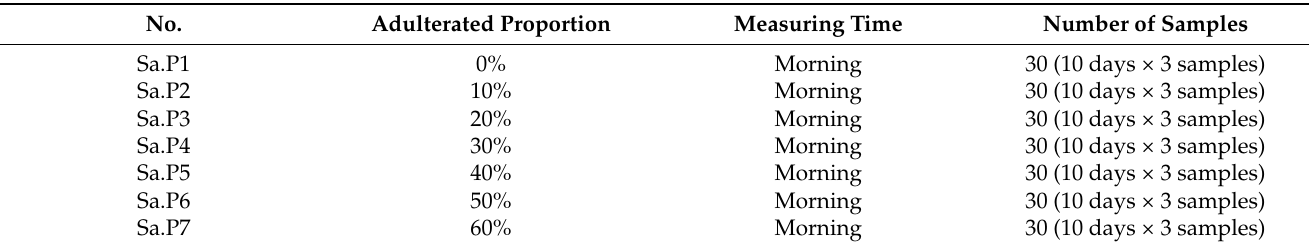
Table 1. Details of the meat samples in Measurement A.